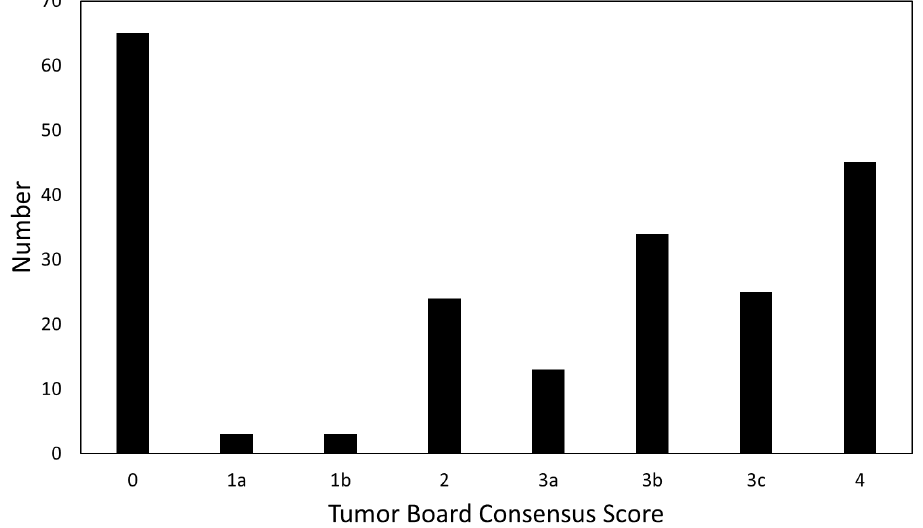
Figure 1. The distribution of tumor board consensus scores for 212 cases presented.